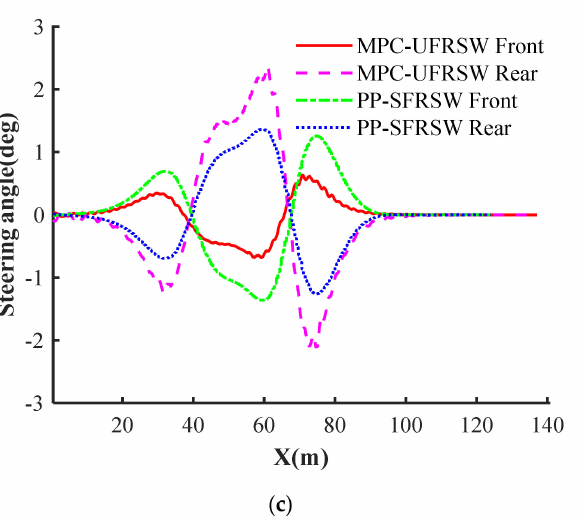
Figure 8. Simulation results of different algorithms. ( a ) Trajectory tracking; ( b ) Lateral error; ( c ) Steer- ing angle.